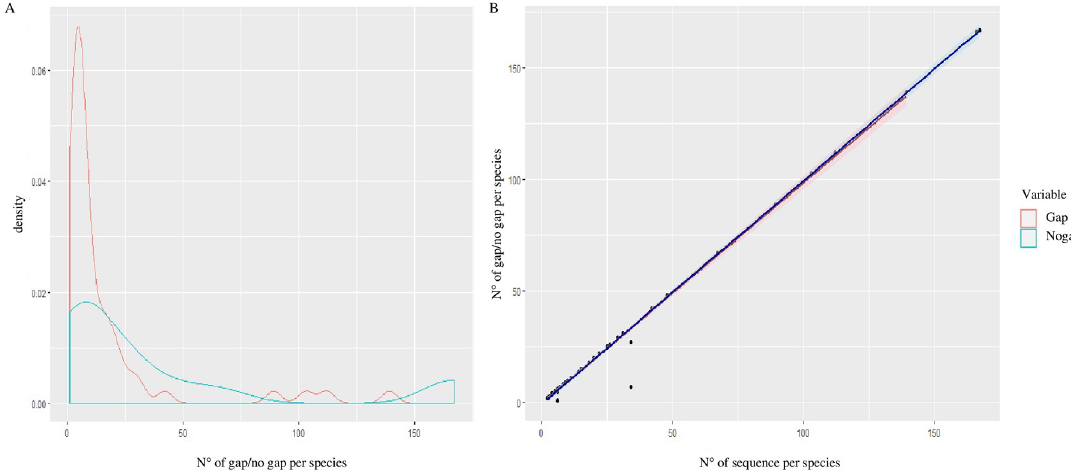
Fig 4. Effect of sequence sampling on the barcoding gap analyses. (a) Kernel Density Plots showing the distribution of instances of absence of the barcoding gap over the total number of sequences available for each species. (b) Linear regression models showing the association between the total number of sequences available for each species and the number instances of presence (red) and absence (blue) of barcoding gap.